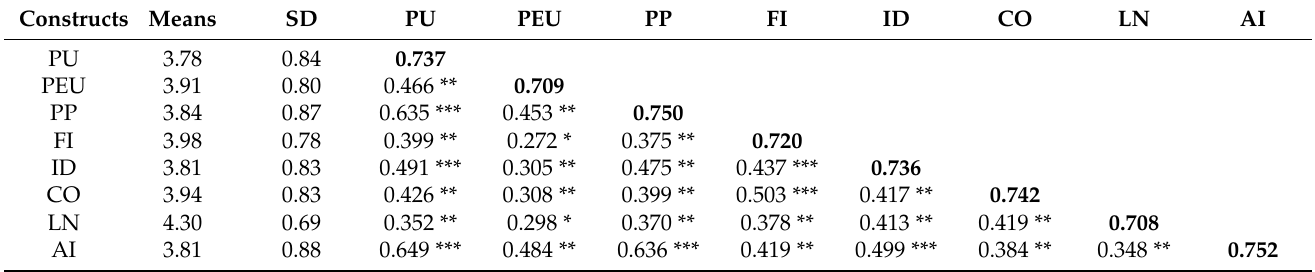
Table 3. Means, standard deviations, and